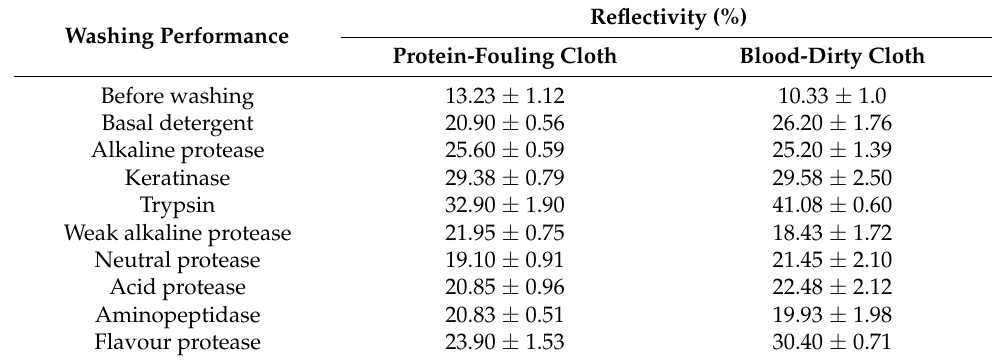
Table 1. Washing performance of protease on protein-fouling and blood-dirty